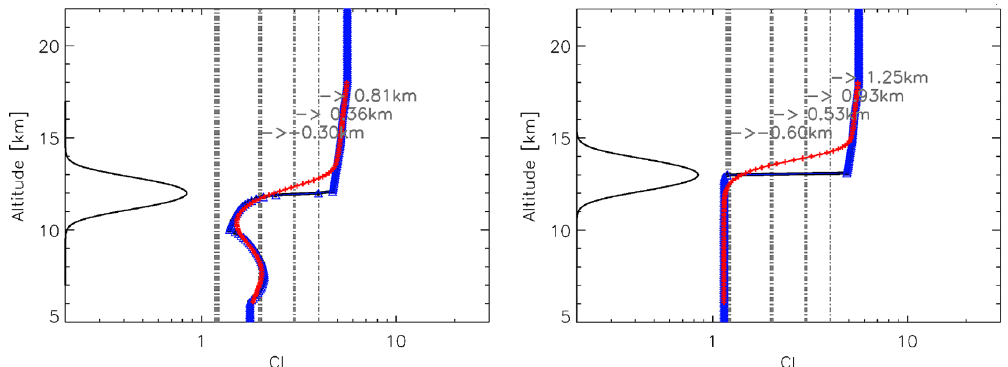
Figure 3. Examples of cloud index profile computed from modelled radiance profiles with high vertical resolution (0.1k˙m, in blue) for a 2km thick cloud layer with cloud top at 12 and 13km for optically thin (left) and thick (right) conditions respectively. The Gaussian-shaped field of view was applied to the pencil beam simulations (blue) to simulate CRISTA profiles (red) (examples of the FOV function are centred on the cloud top at 12 and 13km). The superimposed numbers indicate the maximum errors in CTH, dCTH = [no detection, − 0.30, 0.36, 0.81]km (left), and dCTH = [ − 0.56, 0.53, 0.94, 1.28]km (right) for the corresponding CI threshold values [1.2, 2, 3, 4] applied in the cloud